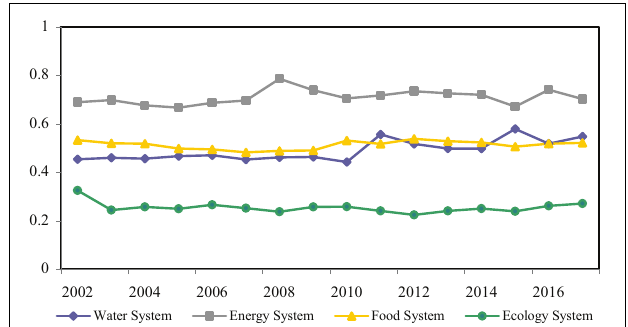
FIGURE 1 | Dynamic evolution of subsystems in Northwest